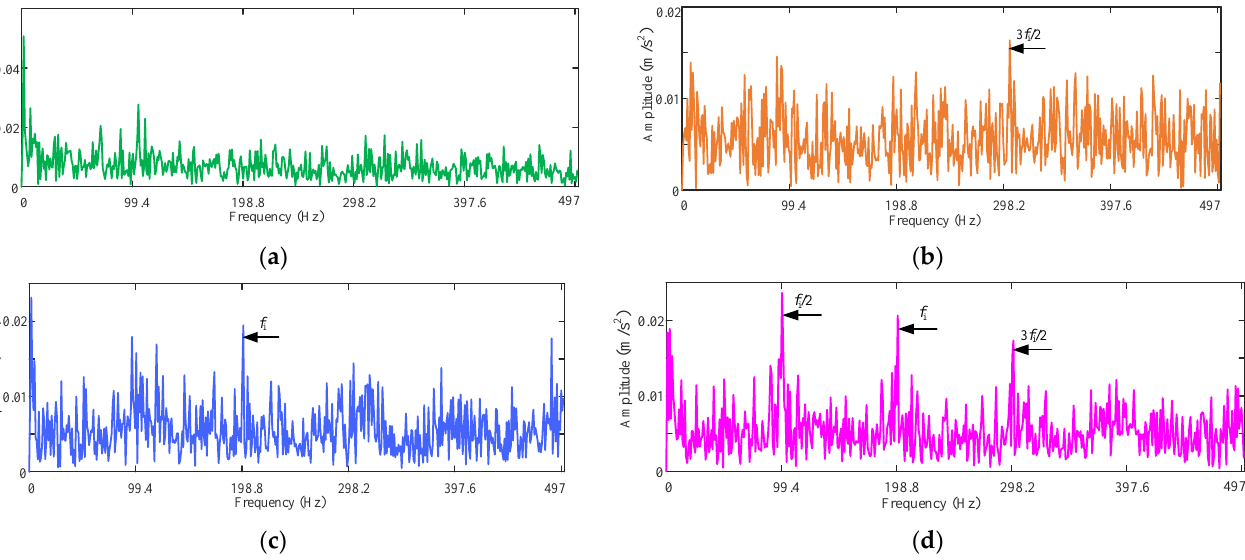
Figure 18. Envelope spectrum of vibration signal and different noise reduction signals in Case 2. ( a ) Envelope spectrum of vibration signal; ( b ) Envelope spectrum of noise reduction signal by AG- UNet; ( c ) Envelope spectrum of noise reduction signal by U-Net; ( d ) Envelope spectrum of noise reduction signal by TA-UNet.